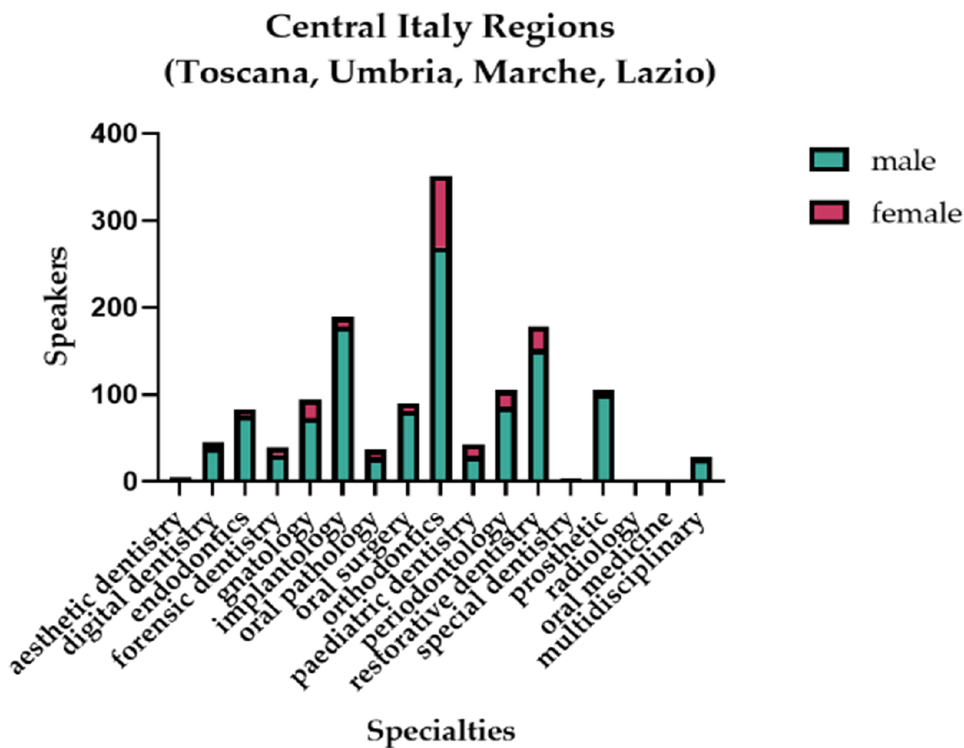
Figure 6. Graphical representation of the gender distribution of the speakers in the central area of Italy.